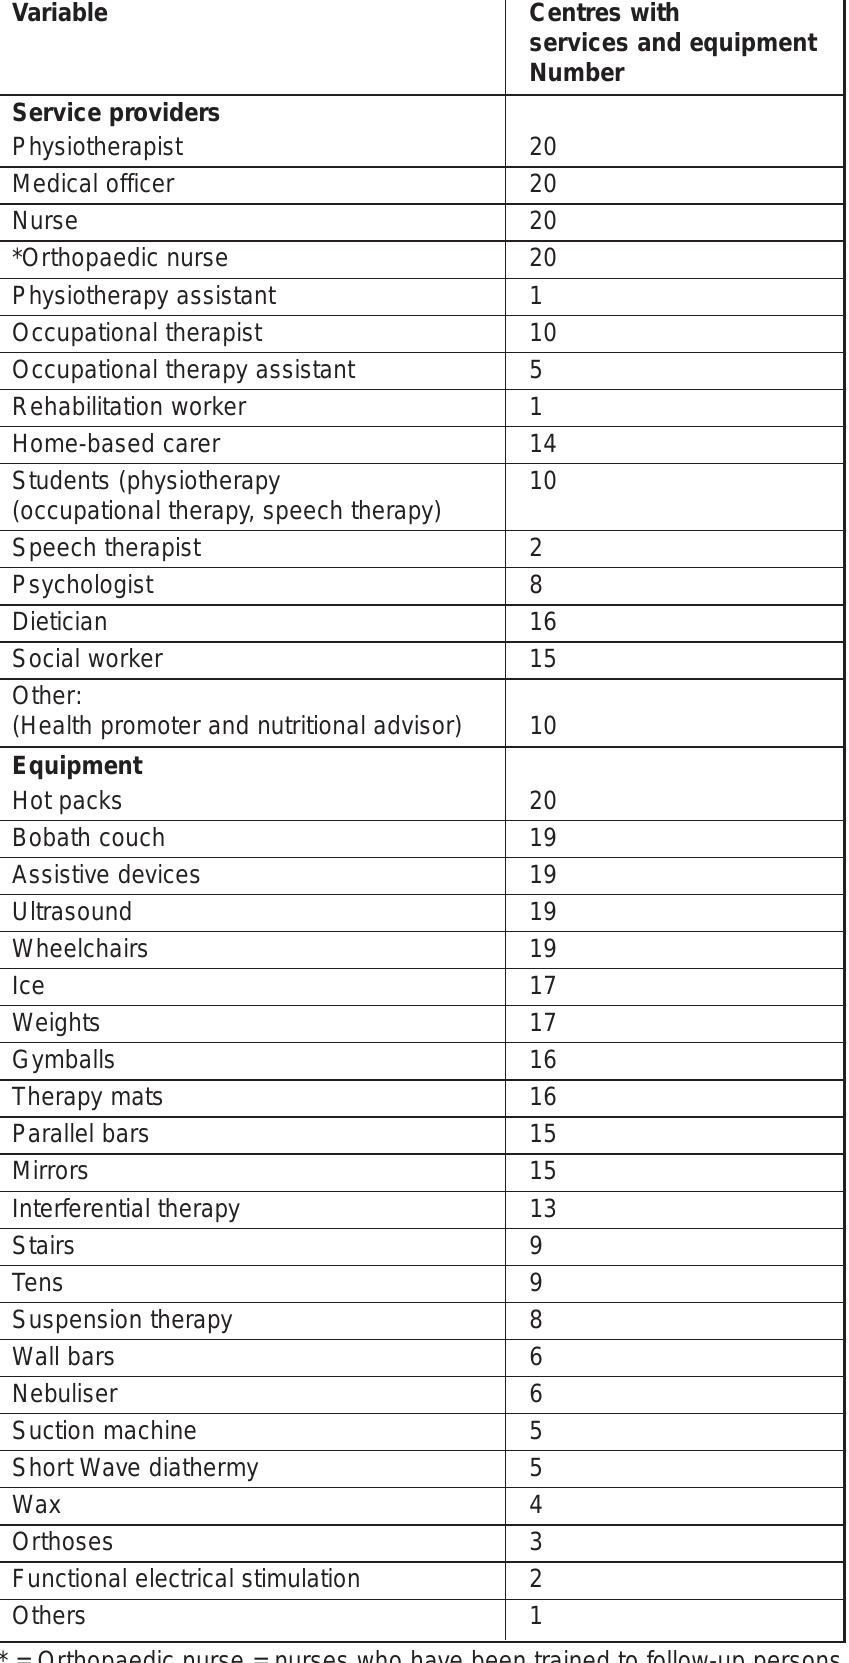
Table 2: Services and equipment available at the 20 CHCs in the Cape Metro District of the Western Cape offering rehabilitation